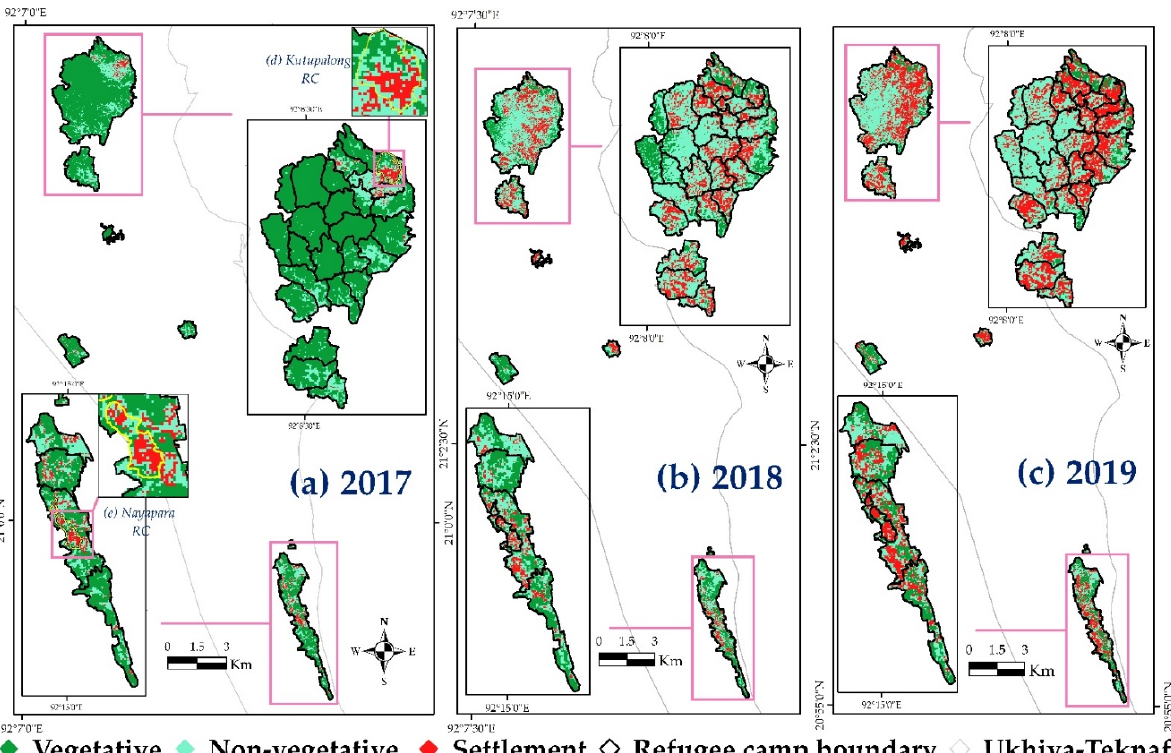
Figure 16. Land cover maps of the thirty-four Rohingya refugee camp areas classified into three major land cover classes, including vegetative, non-vegetative, and settlement represented as green, cyan, and red, respectively, at three time-periods, representing pre-influx ( a ) January 2017, and post-influx ( b ) March 2018, and ( c ) February 2019.